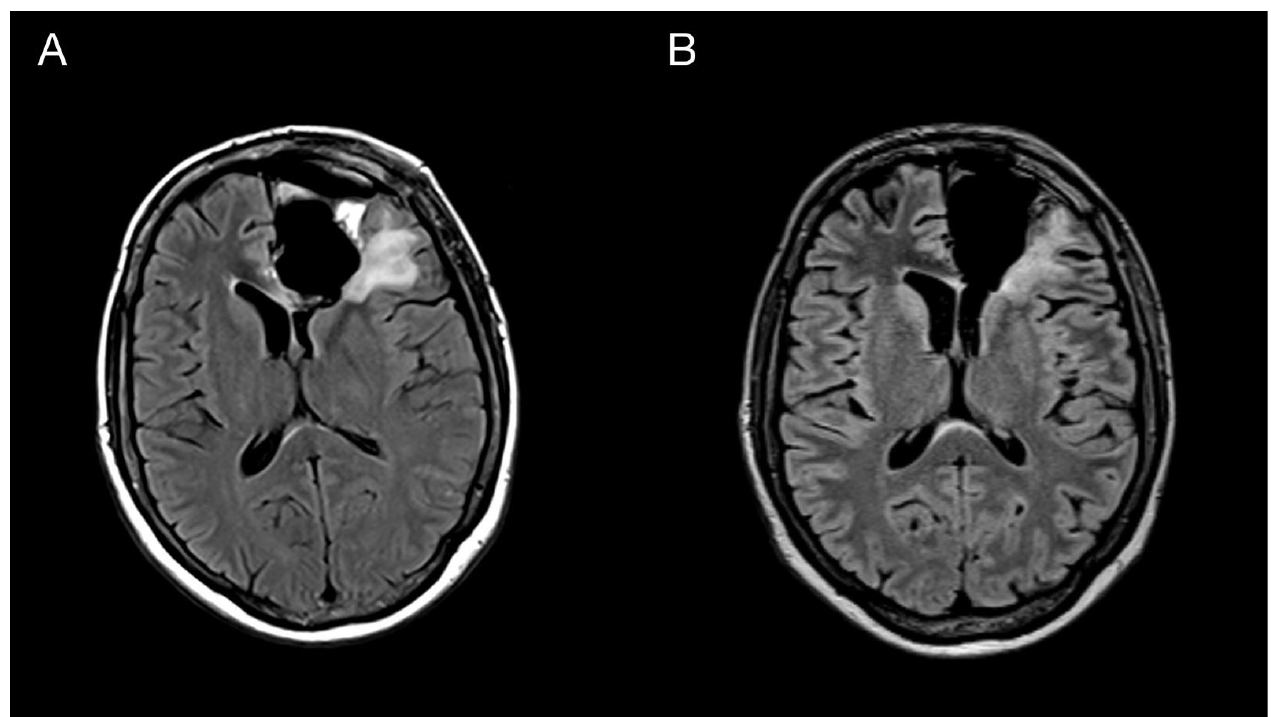
Figure 5. Imaging of the primary brain tumor prior to and after the oncological treatment. Axial brain MRI (fluid-attenuated inversion recovery images) prior to oncological treatment displaying GBM’s rapid early progression in the left frontal lobe ( A ) and two months after the chemo-radiotherapy ( B ).